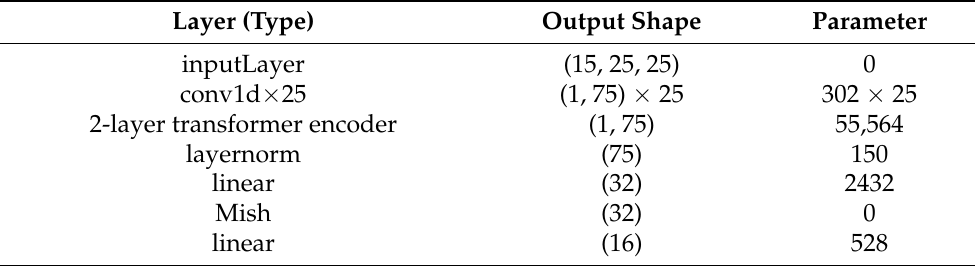
Table 6. Parameter summary of the proposed transformer model architecture over the Salinas data